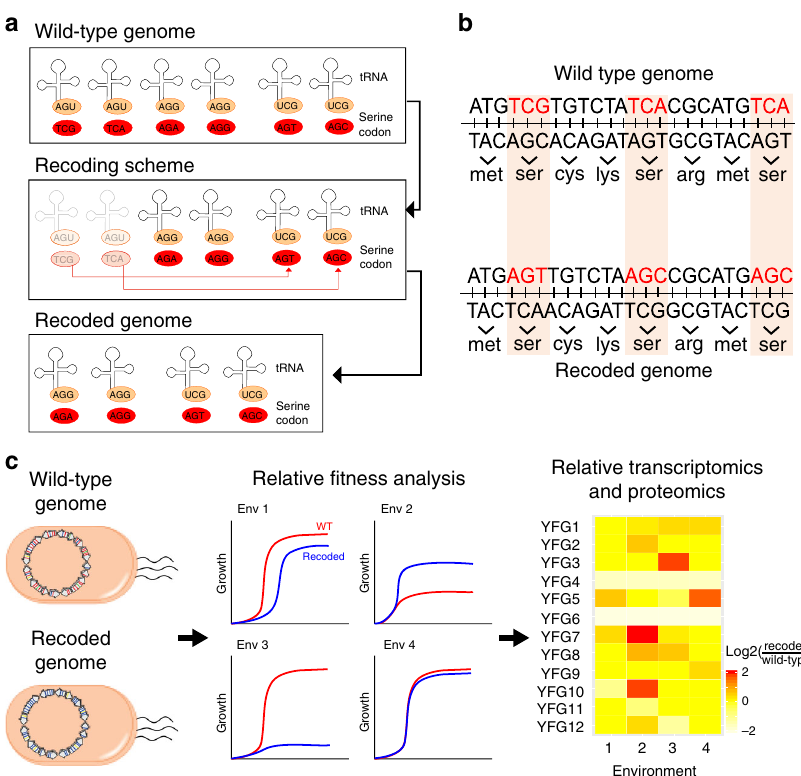
Fig. 3 Recoding. a , b Certain codons can be replaced with alternative codons on a genome-wide scale 11,66,70 . Typically, such recoding involves substituting a codon with a synonymous codon, followed by the deletion of the corresponding tRNA for the original codon. Here, the number of synonymous codons for the serine amino acid is reduced from six to four by the genome-wide substitution of TCG and TCA codons by the synonyms AGT and AGC, respectively. This makes it possible for the codon and tRNA to be repurposed, for example, to incorporate nonnatural amino acids into proteins. However, in the future, recoding efforts may also involve non-synonymous codon substitutions. c Genome-wide recoding can be used to explore how codon usage affects the transcriptome, proteome, and fi tness.